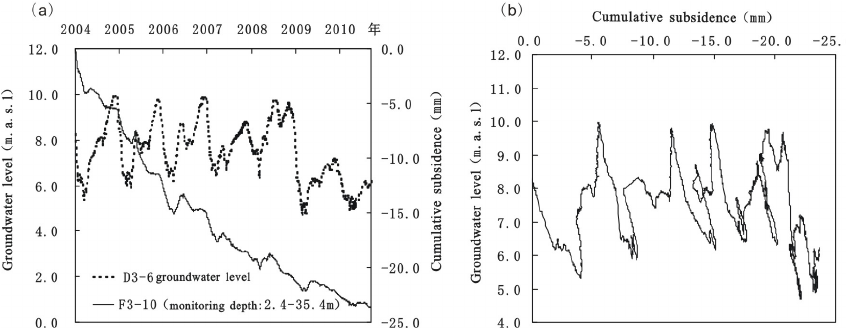
Figure 3. Deformation behavior of shallow soil mass vs. its corresponding groundwater level at layered mark F3-10. (a) Groundwater level and deformation over time, (b) groundwater level vs. deformation hysteresis loops.